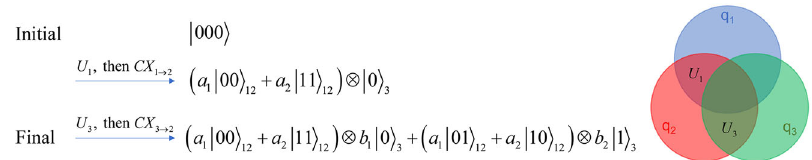
Fig. 2 The case of entangled qubits not sharing any unitary dependence. The fi gure shows the creation process of j ψ i and the fi nal unitary dependence picture represented by a Venn diagram. U